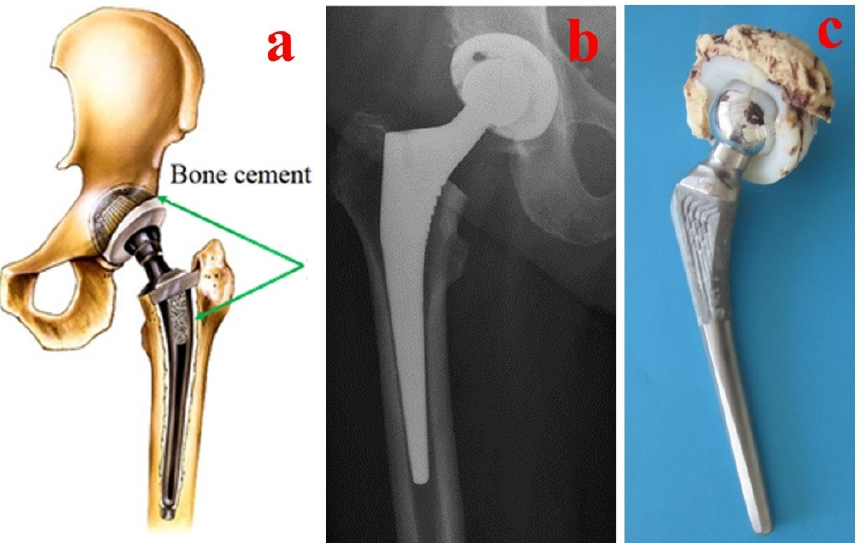
Figure 3. Aspects regarding the handling of bone cements for classical hip prosthesis fixation: ( a ) Bone cement application. ( b ) Postoperative radiography. ( c ) Failed hip prosthesis.